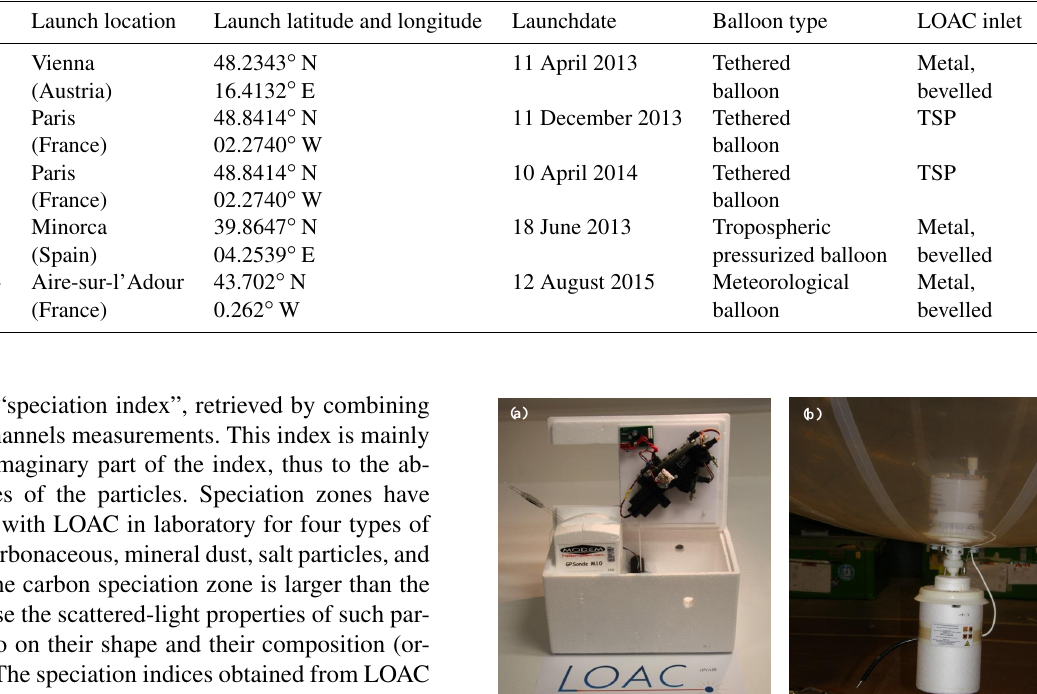
Table 1. LOAC balloon flights illustrated in this study.